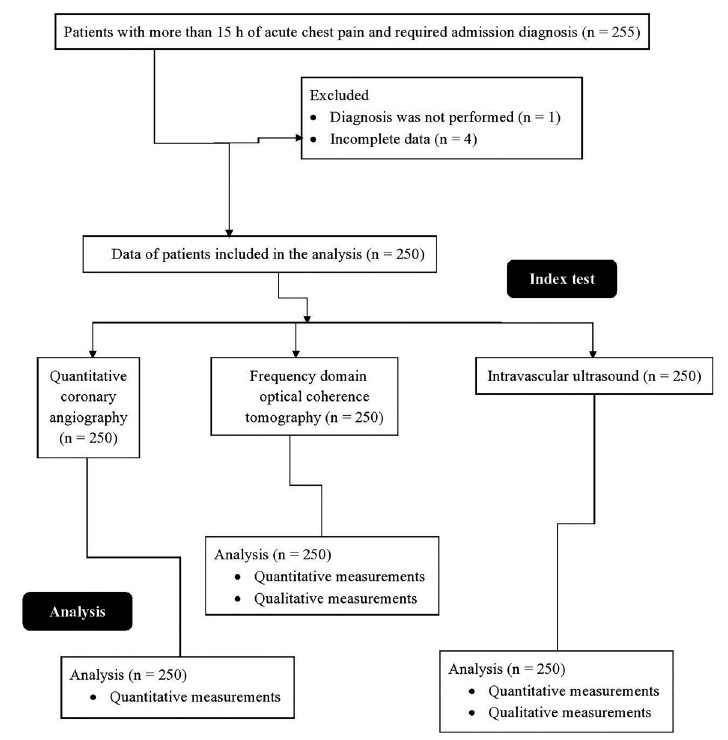
Figure 1. Flow diagram of the